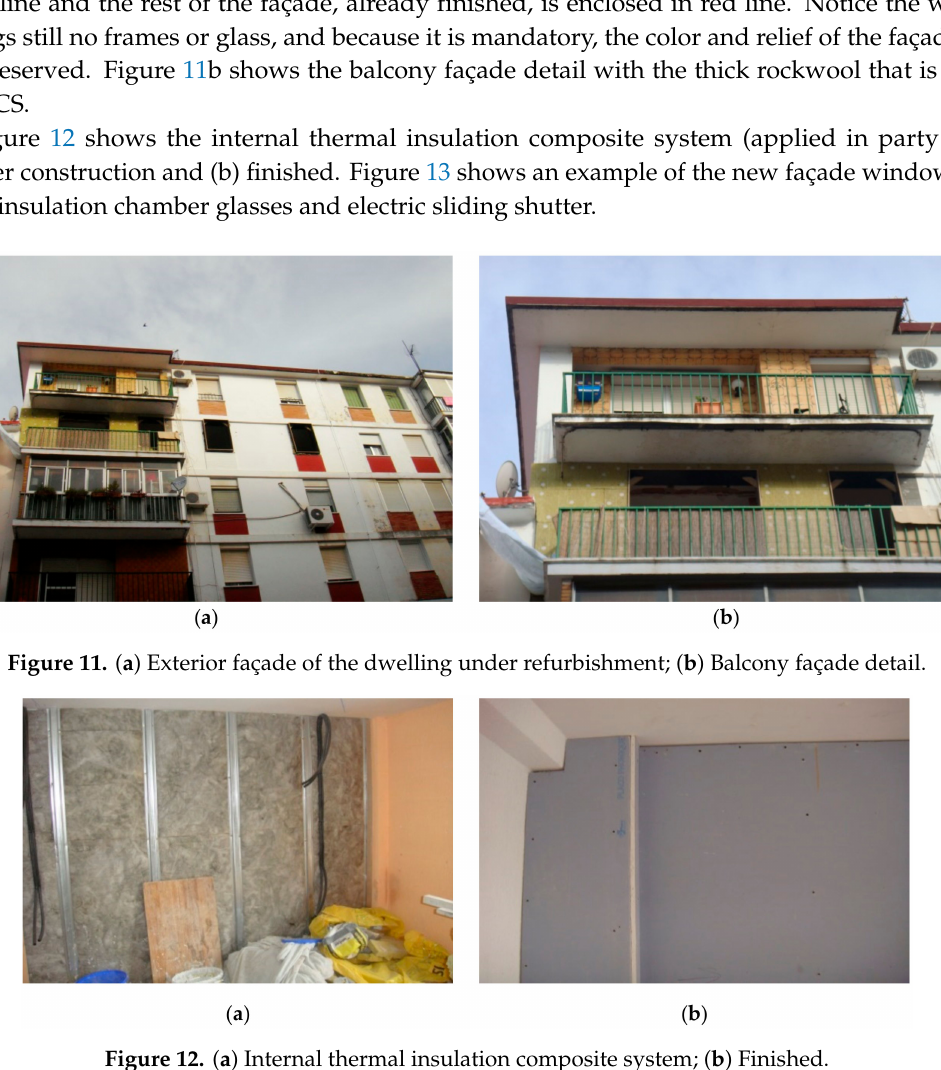
Figure 12. ( a ) Internal thermal insulation composite system; ( b ) Finished.